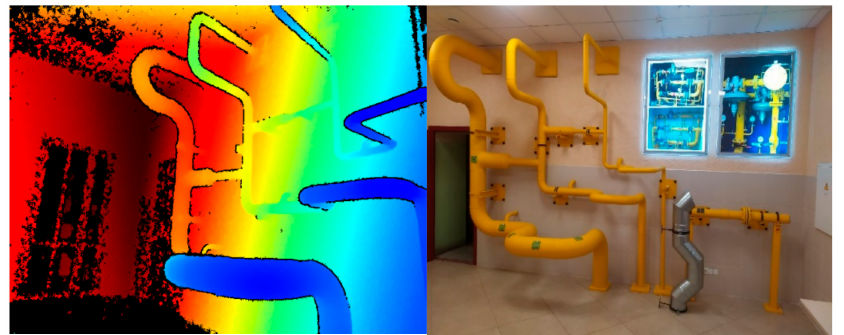
Figure 11. Test rig shot with LIDAR. Copyrighted by authors.